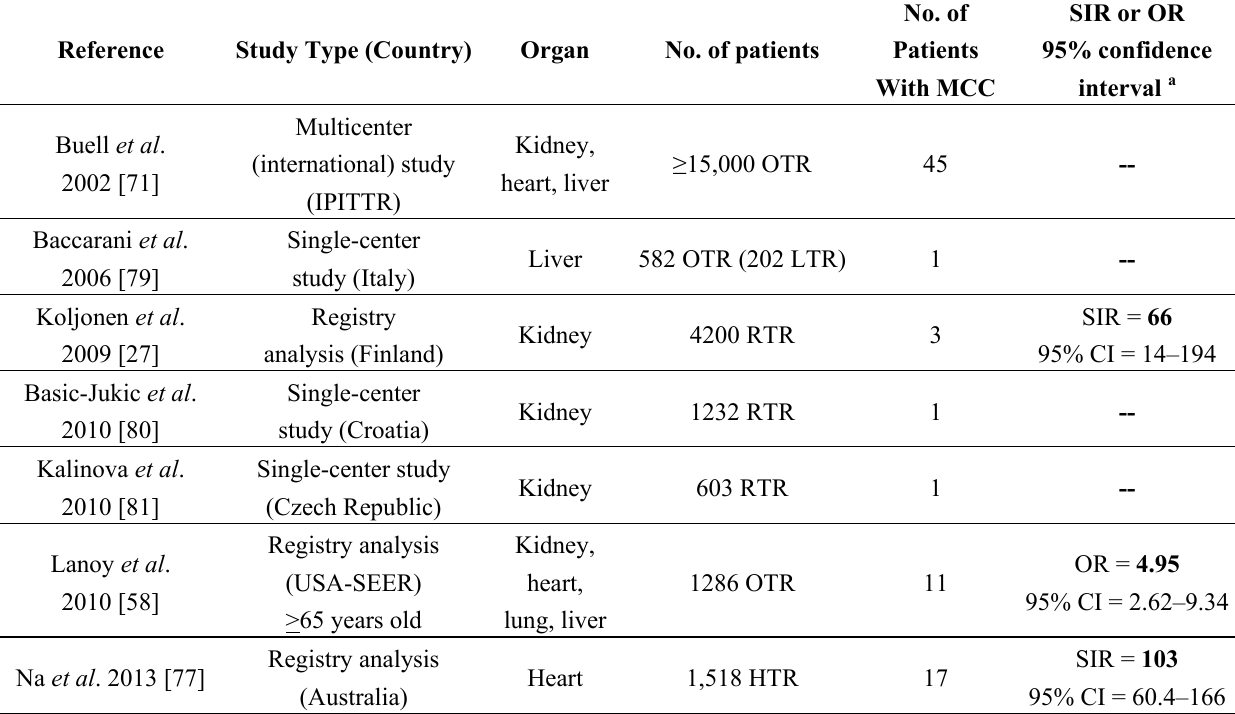
Table 1. Summary of relative risks of MCC occurring after solid organ transplantation. Reference Study Type (Country) Organ No. of patients